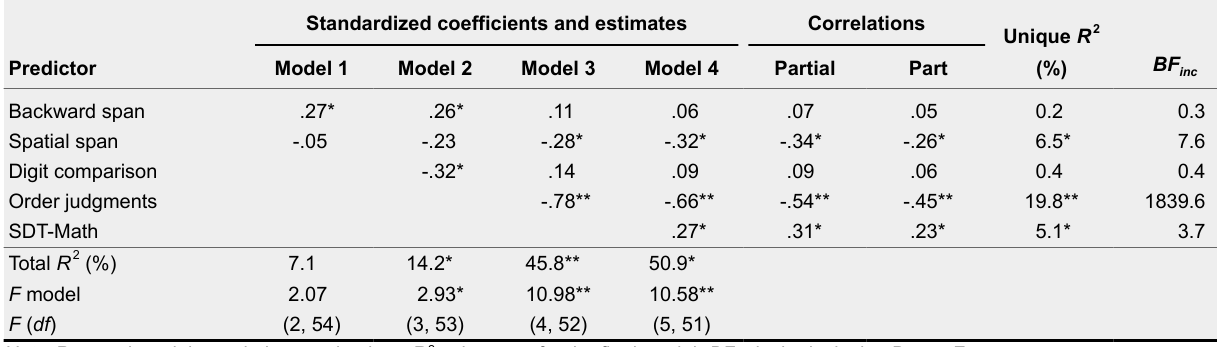
Regression Models for Arithmetic Fluency Standardized coefficients and estimates Predictor